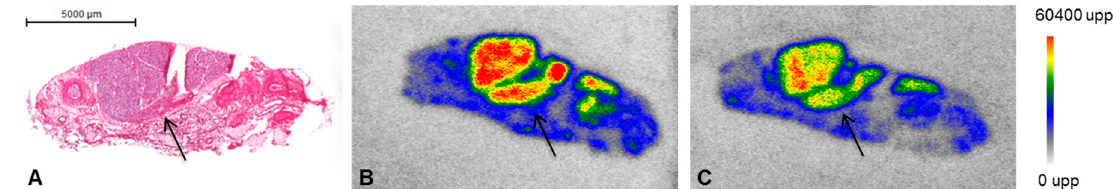
Figure 1. Salivary gland tissue cryosections (pig, 10 µm). Arrows indicate glandular areas. (A) H&E staining; autoradiography after incubation for 1.5 h at ambient temperature with 80 nM [ 177 Lu]Lu- PSMA-617 showing total binding (B) and additional incubation with 80 µM 2-PMPA (highly potent PSMA-inhibitor) indicating non-specific binding (C).